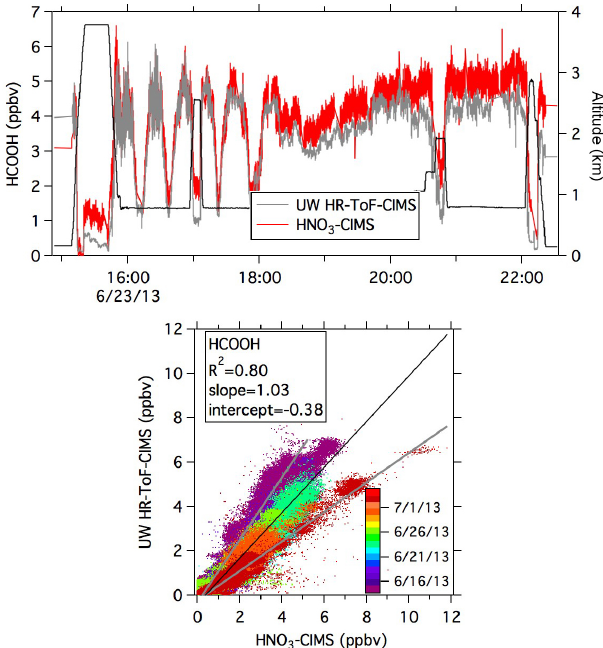
Figure 5. HCOOH inter-comparison between the HNO 3 -CIMS and the UW HR-ToF-CIMS as a time series for a selected flight and a scatter plot. The color code in the scatter plot indicates all the indi- vidual flights. The black line is a fit using all the data the grey lines fits for individual flights with the highest or lowest slope, respec-